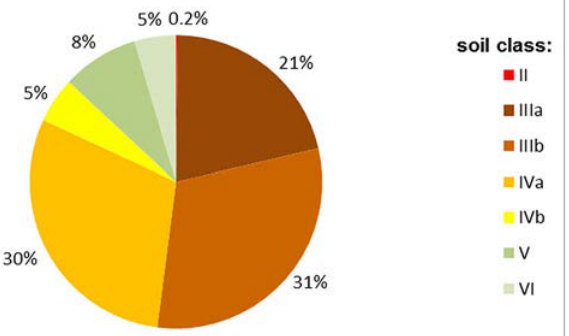
Fig. 4. Quality of farmland on built-up housing lots in Rokietnica commune, 2014. Source: own compilation on the basis of data from the Poviat Centre of Geodetic and Cartographic Documenta- tion in